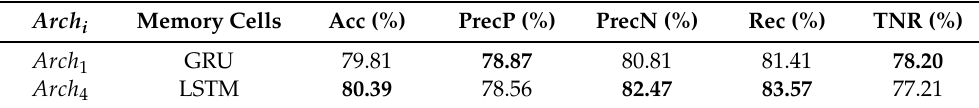
Table 5. Results of gated recurrent unit (GRU) and long short-term memory (LSTM) experiment on the testing dataset.